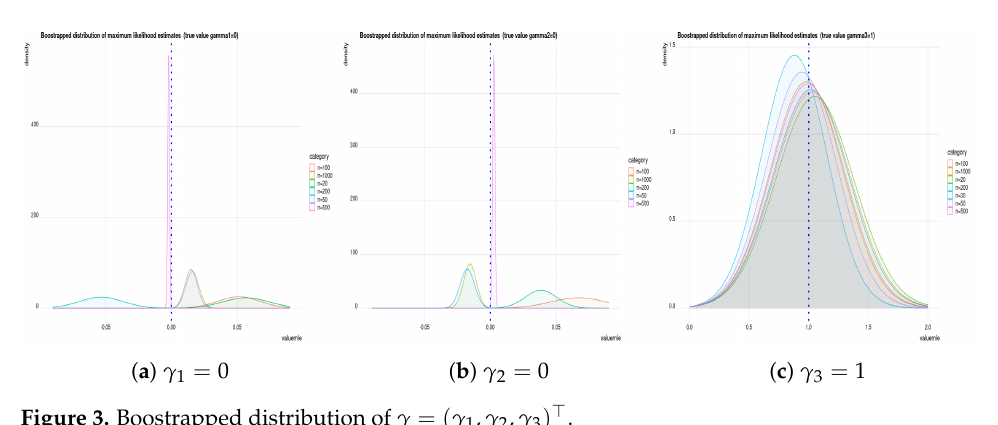
Figure 3. Boostrapped distribution of γ = ( γ 1 , γ 2 , γ 3 ) (cid:62) .